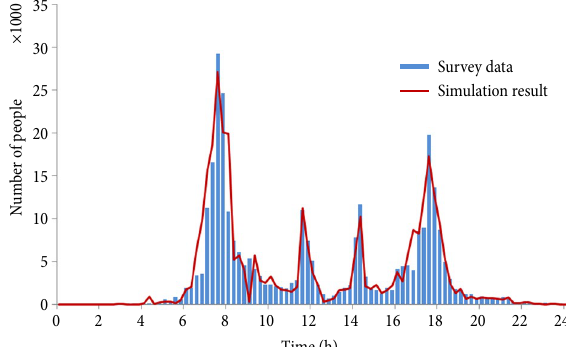
Fig. 4. Temporal flow of traffic distribution from survey data and from simulation using the multi-agent-based